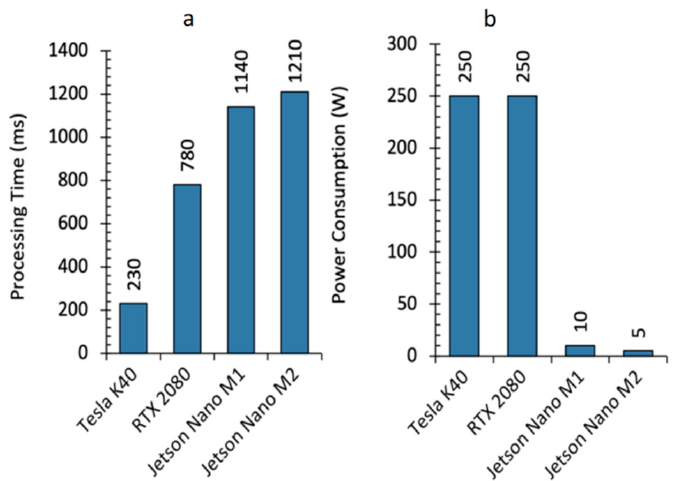
Figure 5. Deployment performance. ( a ) Processing time and ( b ), power consumption comparisons of the different NVIDIA GPUs considered in this study. Jetson Nano M1 and Jetson Nano M2 indicate the two possible power configurations of the Jetson Nano board, which are 10 and 5 W of power budget, respectively.